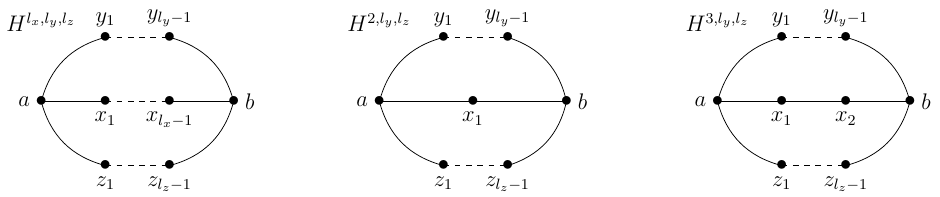
Fig. 6: This figure shows, from left to right, a graphic representation of (a general) H l x ,l y ,l z , and the particular cases of H 2 ,l y ,l z and H 3 ,l y ,l z